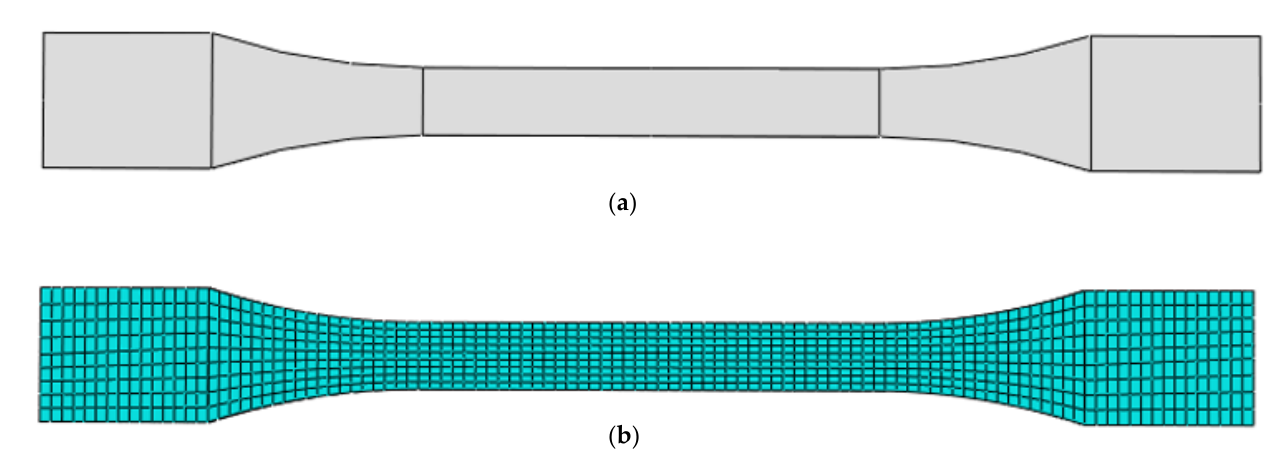
Figure 3. ( a ) part and ( b ) meshed model PLA-coconut fibre reinforced composite.